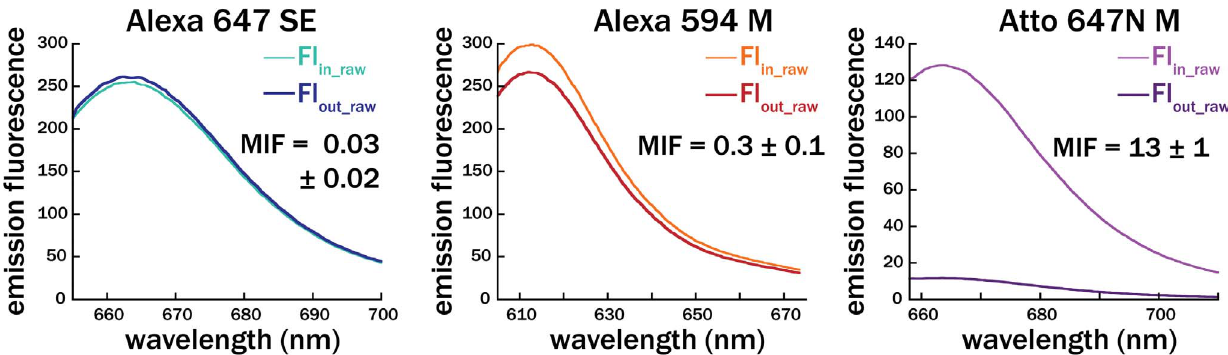
Figure 1. Example raw fluorescence spectra of three dyes. The dyes are representative of low (Alexa 647-SE), moderate (Alexa 594-M), and high (Atto 647N-M) MIF values. Fl in_raw is the raw fluorescence spectrum of the vesicle solution inside the dialysis cassette, collected and prepared as described above. Fl out_raw is the raw fluorescence spectrum of the solution outside the dialysis cassette. MIF values are the corrected MIF values averaged across three separate measurements, as reported in Table 1. Emission fluorescence is in arbitrary units.